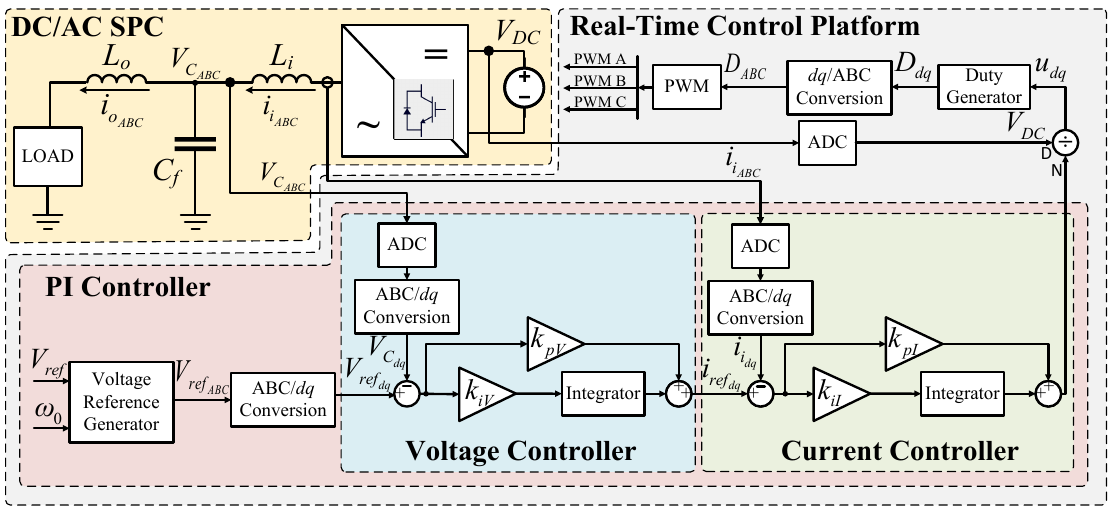
Figure 6. General structure of the PI controller for a DC/AC